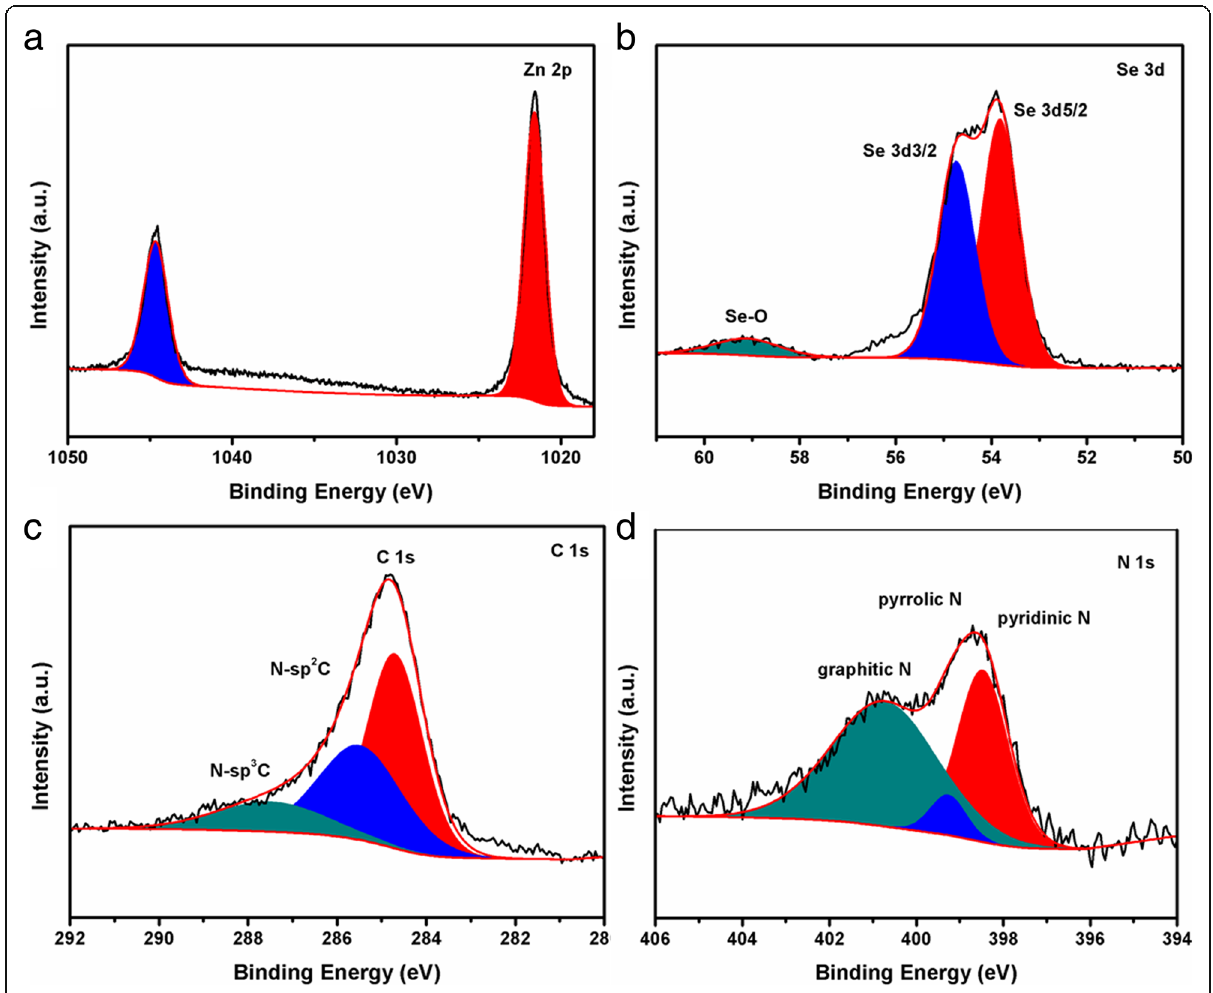
Fig. 5 High-resolution XPS spectra of ZnSe/NC-300 a Zn 2p, b Se3d, c N 1s, and d C